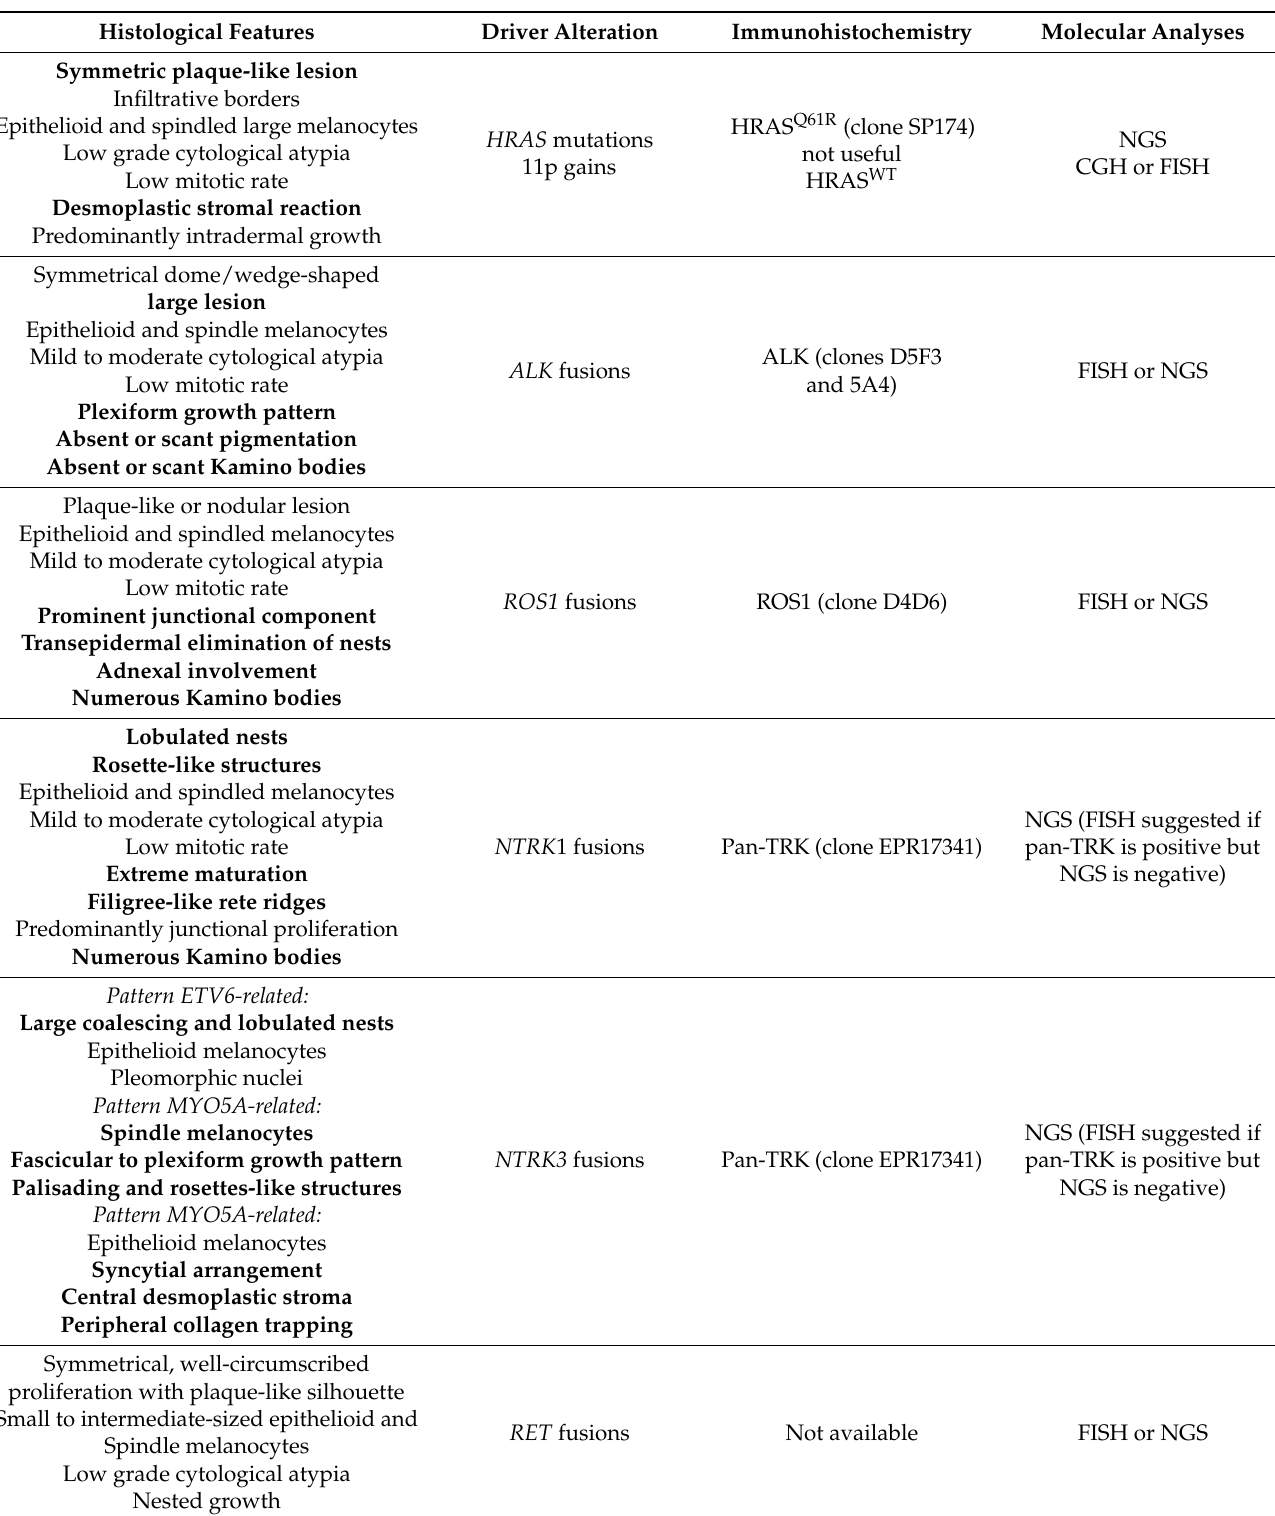
Table 2. Morpho-molecular features of Spitz neoplasms and immunohistochemistry and/or molec- ular analyses useful for diagnostic confirmation. Histological features more characteristic of each molecular subtype are in